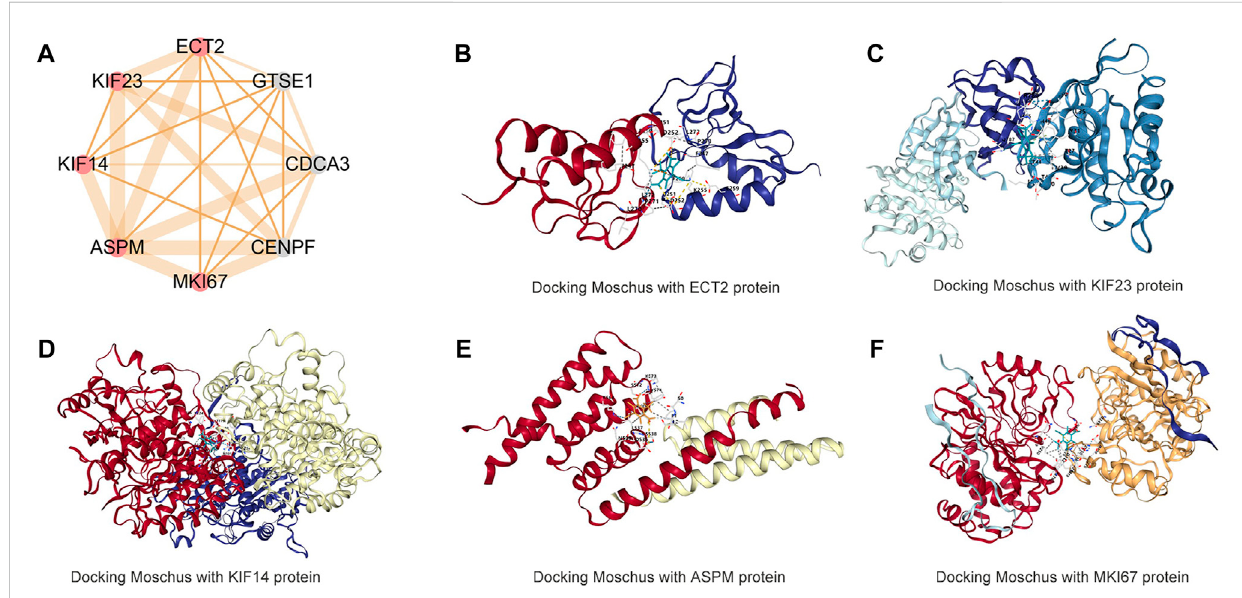
FIGURE 7 Molecular docking Moschus with hub targets ofCAHM (A) hub targets of CAHM via MCODE algorithms (B) Docking Moschus with ECT2 protein. (C) Docking Moschus with KIF23 protein. (D) Docking Moschus with KIF14 protein. (E) Docking Moschus with ASPM protein. (F) Docking Moschus with MKI67